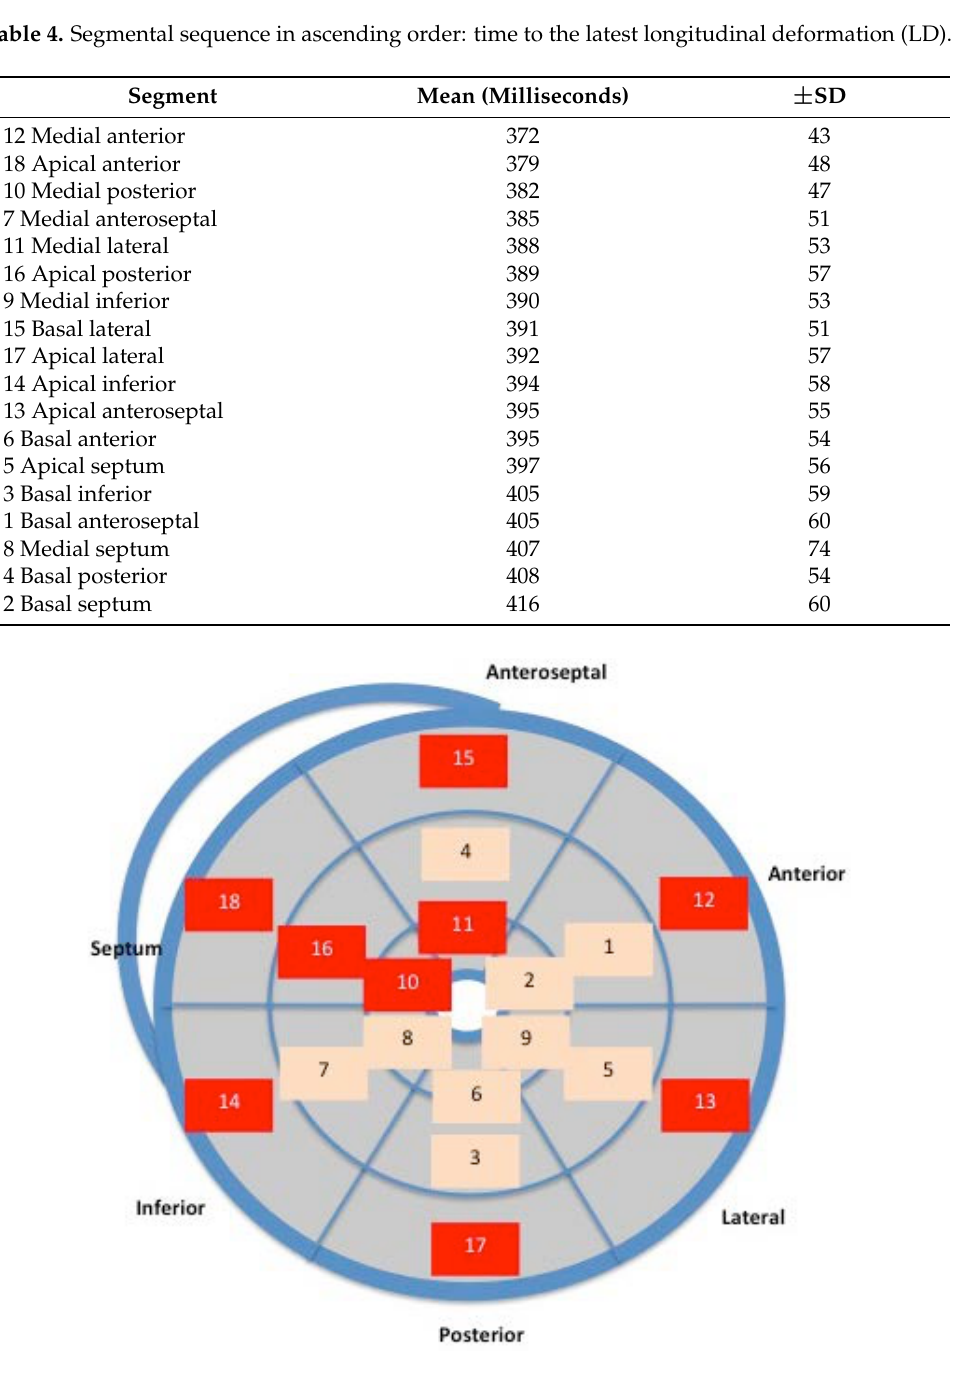
Table 4. Segmental sequence in ascending order: time to the latest longitudinal deformation (LD).